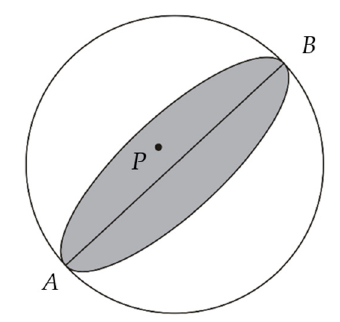
Figure 2. Illustration of the Fresnel zone.